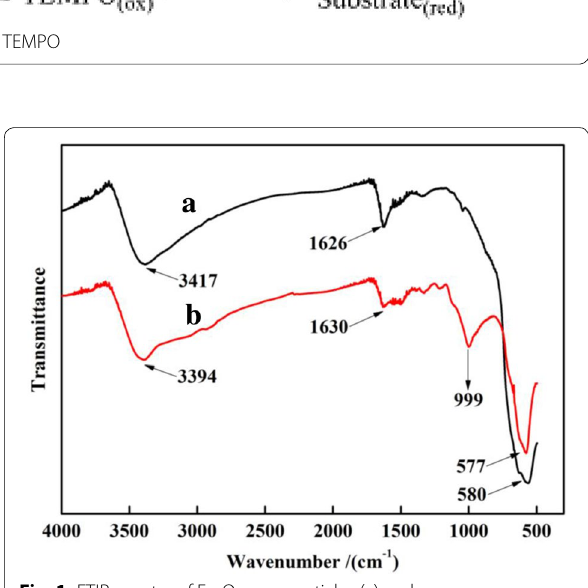
Fig. 1 FTIR spectra of Fe 3 O 4 nanoparticles (a) and amino-functionalized Fe and overlapped by the O–H stretching